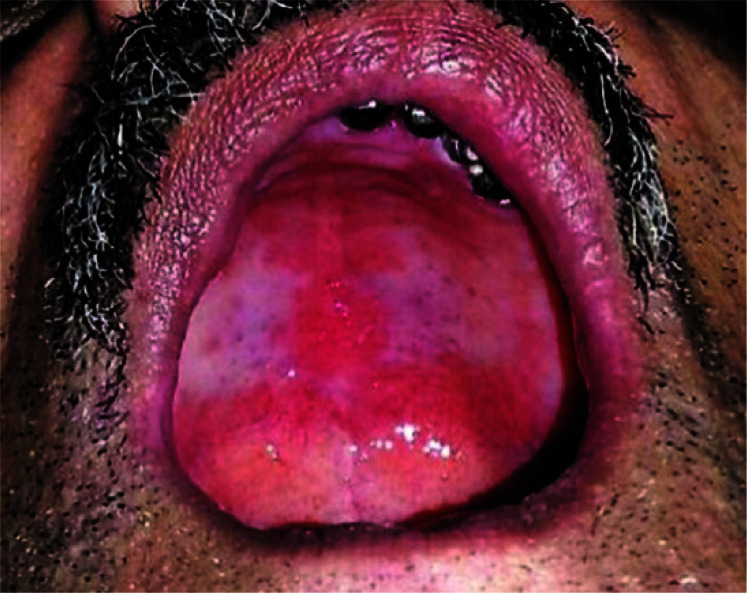
 Erythema before treatment with ZM